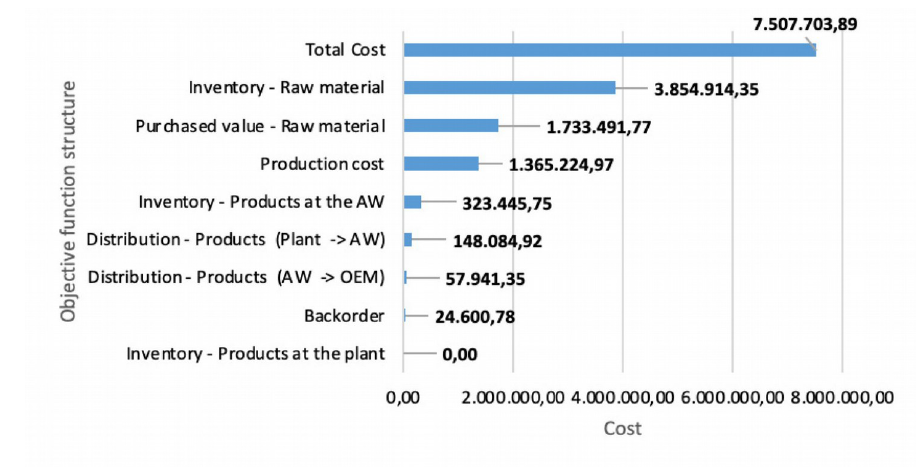
Figure 4. Objective function-Cost